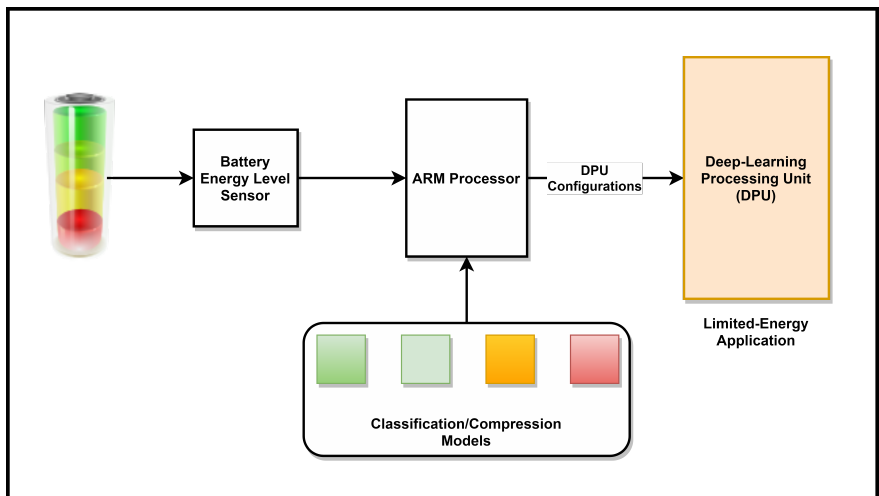
Figure 8. Energy adaptive DPU